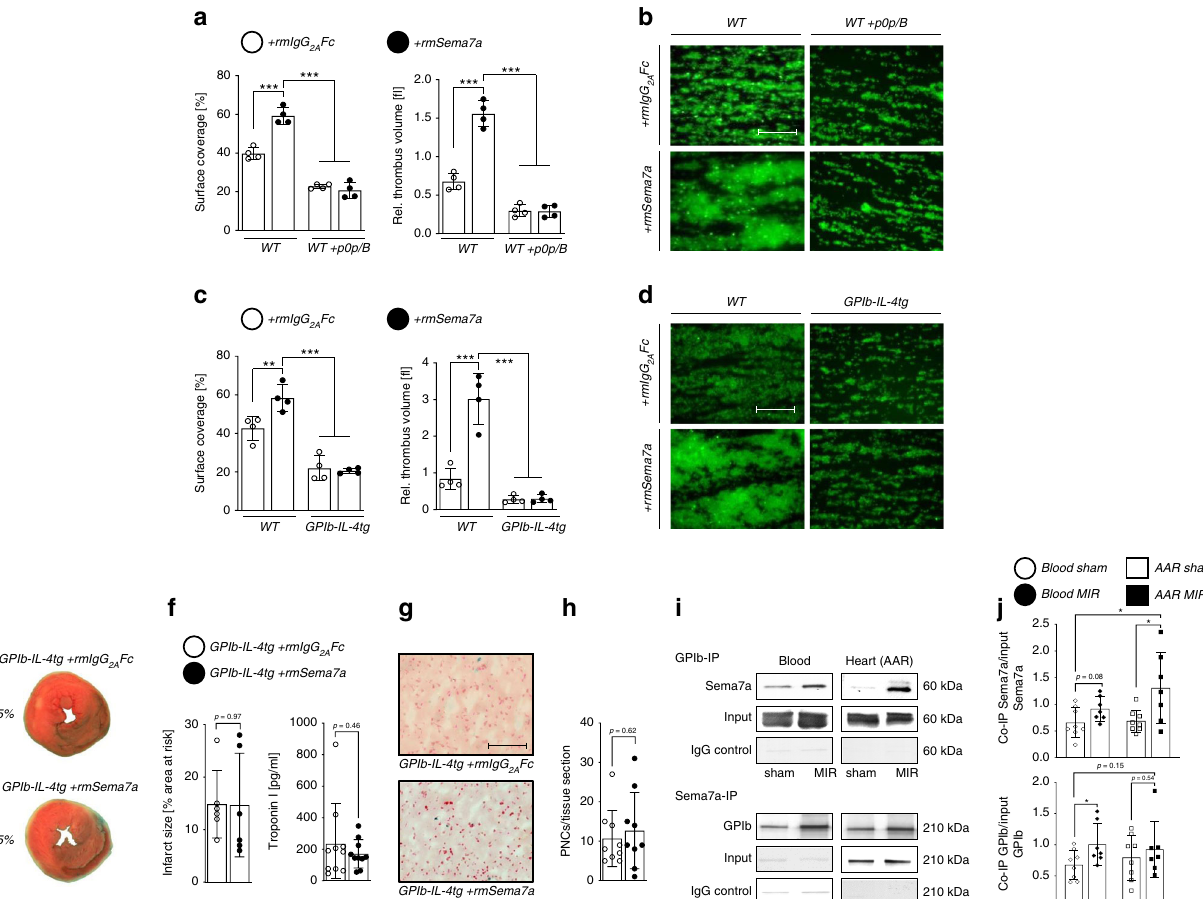
Fig. 5 Sema7a exerts its function through platelet glycoprotein Ib (GPIb). a rmSema7a markedly enhances adhesion and thrombus formation of WT platelets on collagen under fl ow at a shear rate of 1000 s – 1 . Blockade of the ligand-binding site of platelet GPIb (p0p/B) abolishes this thrombus-promoting effect of rmSema7a ( n = 4/group). b Representative IF images (scale bar 50 µ m) of the experiment in a . c rmSema7a does not affect adhesion or thrombus formation of GPIb-IL-4-tg platelets on collagen under fl ow at a shear rate of 1000s − 1 ( n = 4/group). d Representative IF images (scale bar 50 µ m) of the experiment in c . The representative fl uorescence images as well as the mean surface coverage and relative thrombus volume are shown, as measured by integrated fl uorescence intensity (IFI) per mm 2 . e GP-Ib-IL-4-tg animals were exposed to 60 min of ischemia and 120 min of reperfusion. They were injected with rmSema7a or rmIgG 2A Fc control right before ischemia. f Infarct sizes ( n = 6/group) and correlating troponin I plasma levels were determined ( n = 10/group). g Representative histology sections (scale bar 100 µ m) and h number of PNCs counted from myocardial tissue sections of GP-Ib-IL-4-tg injected with either rmSema7a or rmIgG 2A Fc (control, n = 9/group). i Co-immunoprecipitation analysis was performed between Sema7a and GPIb